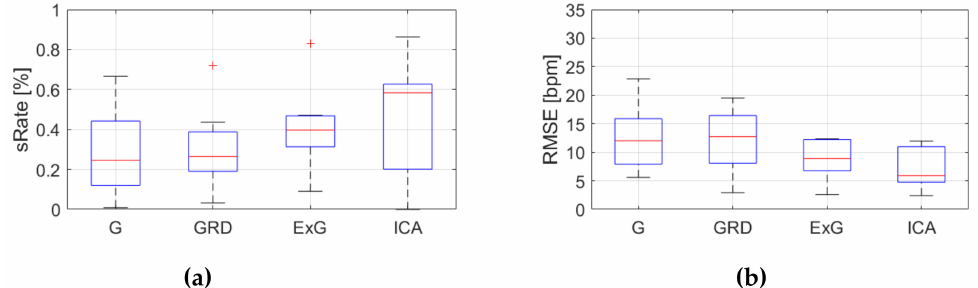
Figure 15. Comparison of signal extraction methods, algorithm No.2 (AR), part 4: ( a ) box plots for sRate ; ( b ) box plots for RMSE . Blue lines—IQR range, red line—median value.